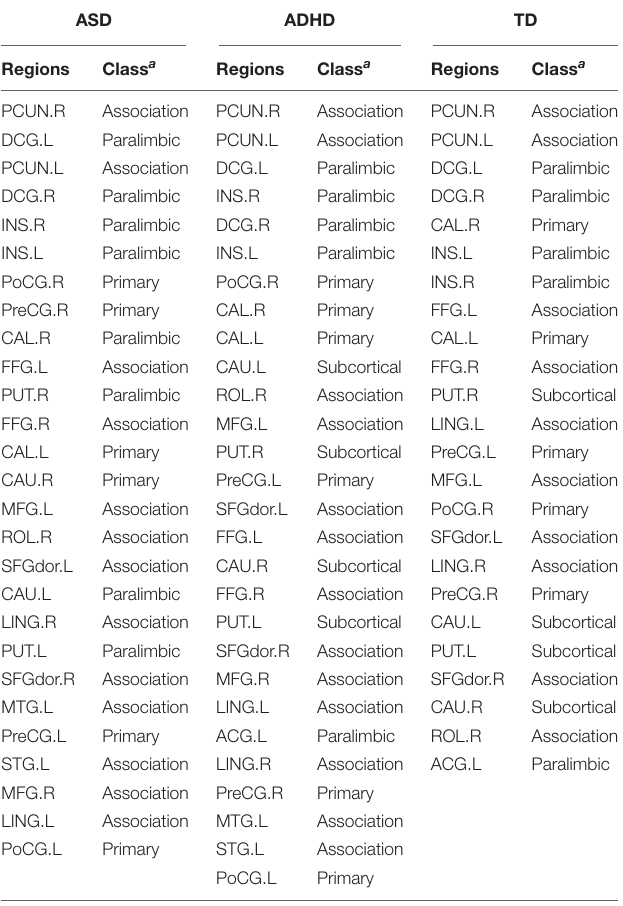
TABLE 4 | Hub distributions of the WM structural networks among the ASD, ADHD, and TD groups. ASD ADHD